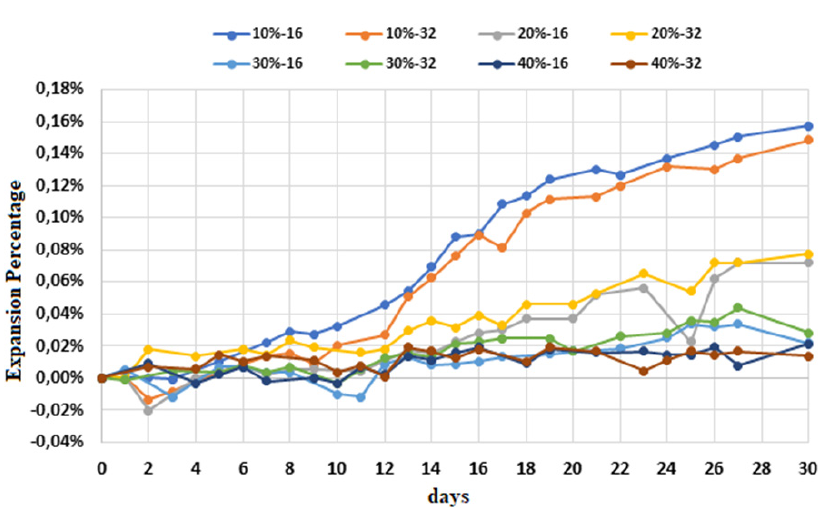
Figure 6. Mortar bars sample expansion with respect to GLR